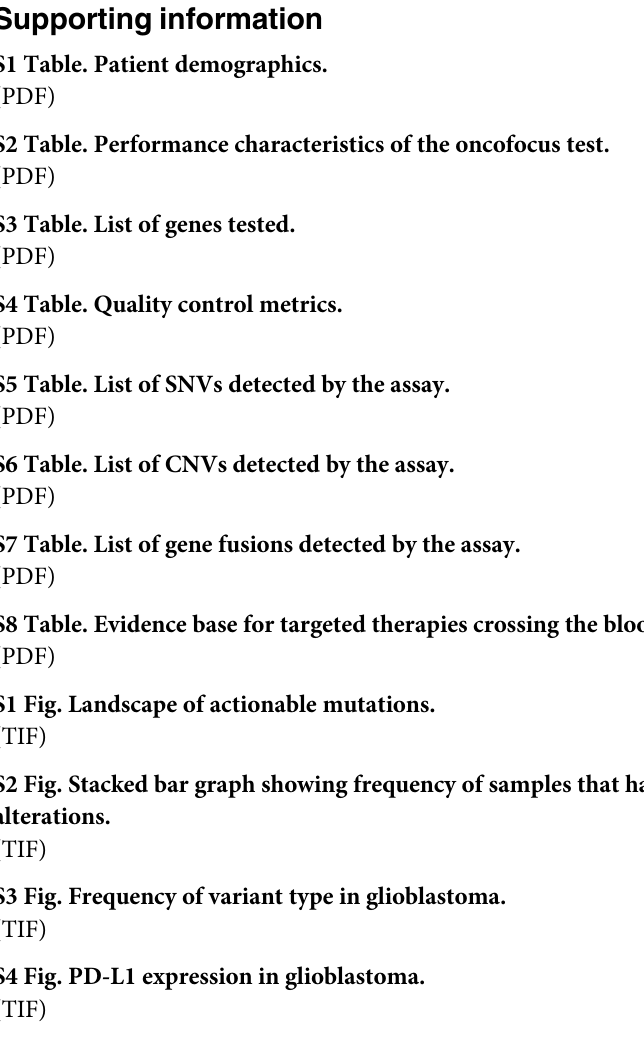
S2 Table. Performance characteristics of the oncofocus test. S3 Table. List of genes tested. S4 Table. Quality control metrics. S5 Table. List of SNVs detected by the assay. S6 Table. List of CNVs detected by the assay. S7 Table. List of gene fusions detected by the assay. S8 Table. Evidence base for targeted therapies crossing the blood brain barrier. S1 Fig. Landscape of actionable mutations. S2 Fig. Stacked bar graph showing frequency of samples that have between 0–9 actionable alterations. S3 Fig. Frequency of variant type in glioblastoma. S4 Fig. PD-L1 expression in